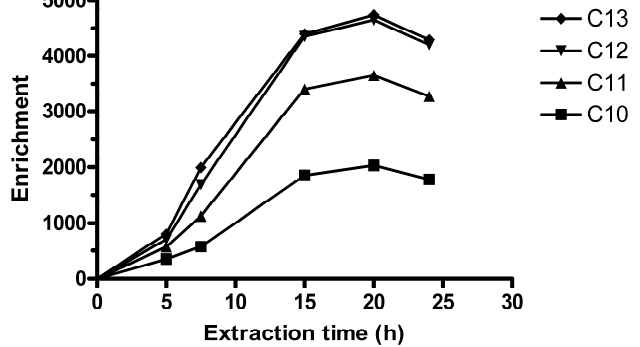
Figure 1. Enrichment as a function of extraction time for 65 mM phosphate buffer at pH 12 ( n = 3). Nominal linear alkylbenzene sulfonates (LAS) sample concentration